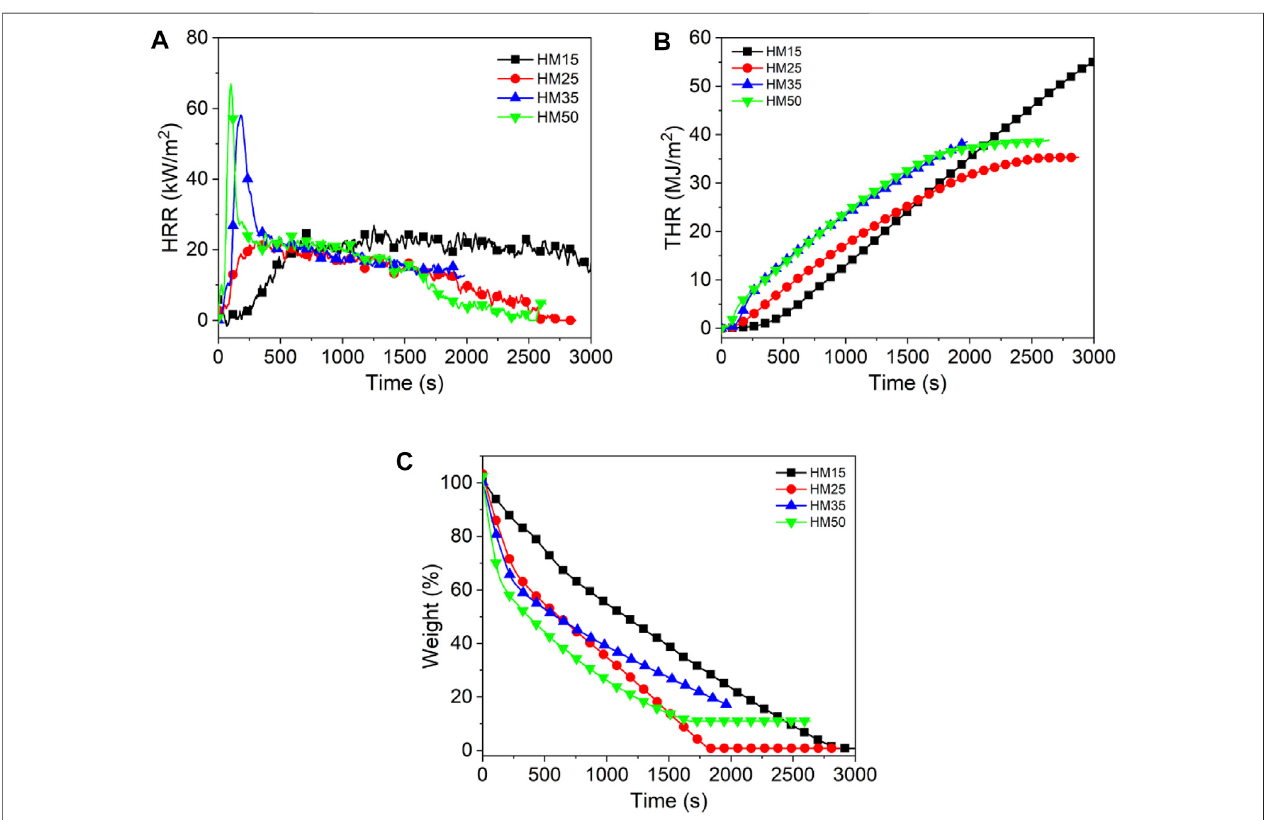
FIGURE 1 | Lignite curves: (A) HRR, (B) THR, and (C) Char residue.